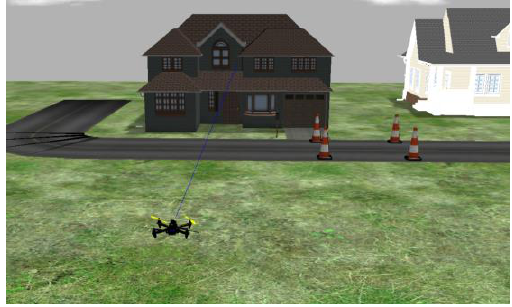
Figure 5. 3D Outdoor environment